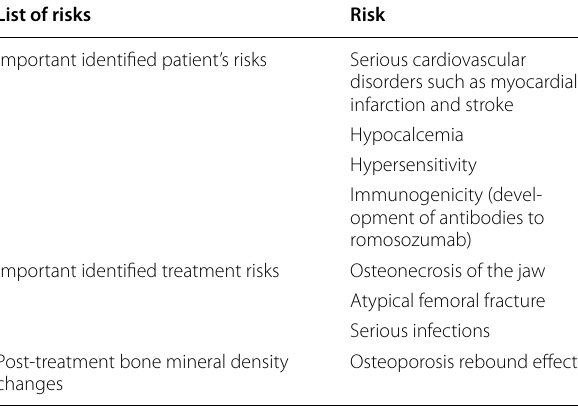
Table 1 List of important risks linked to romosozumab therapy List of